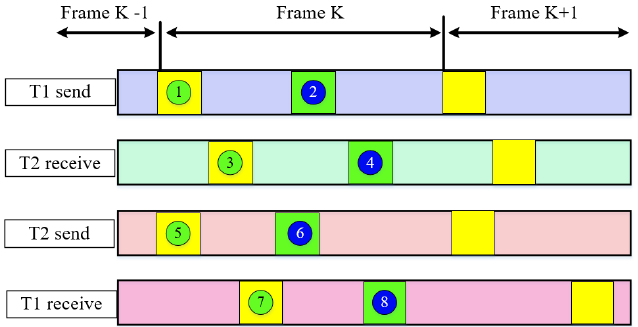
Figure 1. Transmission frame format and timing relationship of the DWAPC-TSM system.